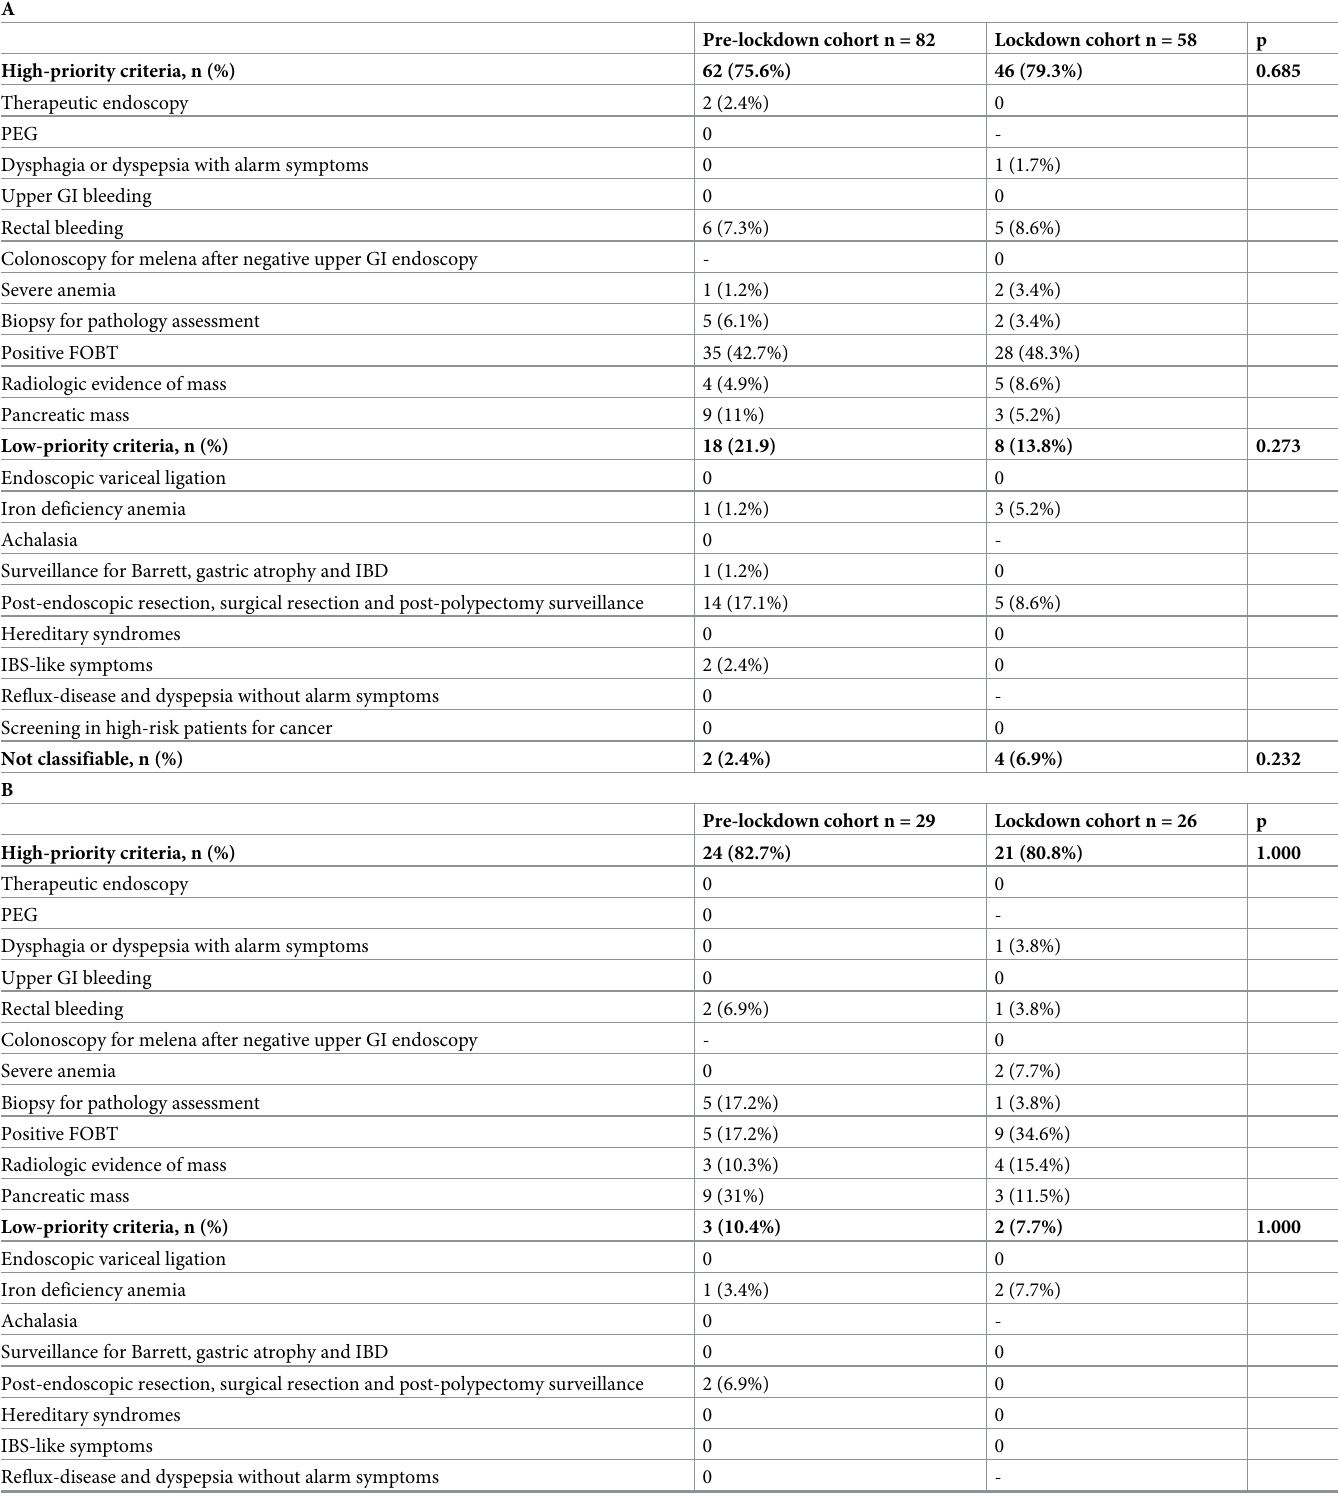
Table 4. Advanced neoplasia/cancer (A) and cancer (B) according to the ESGE high and low-priority